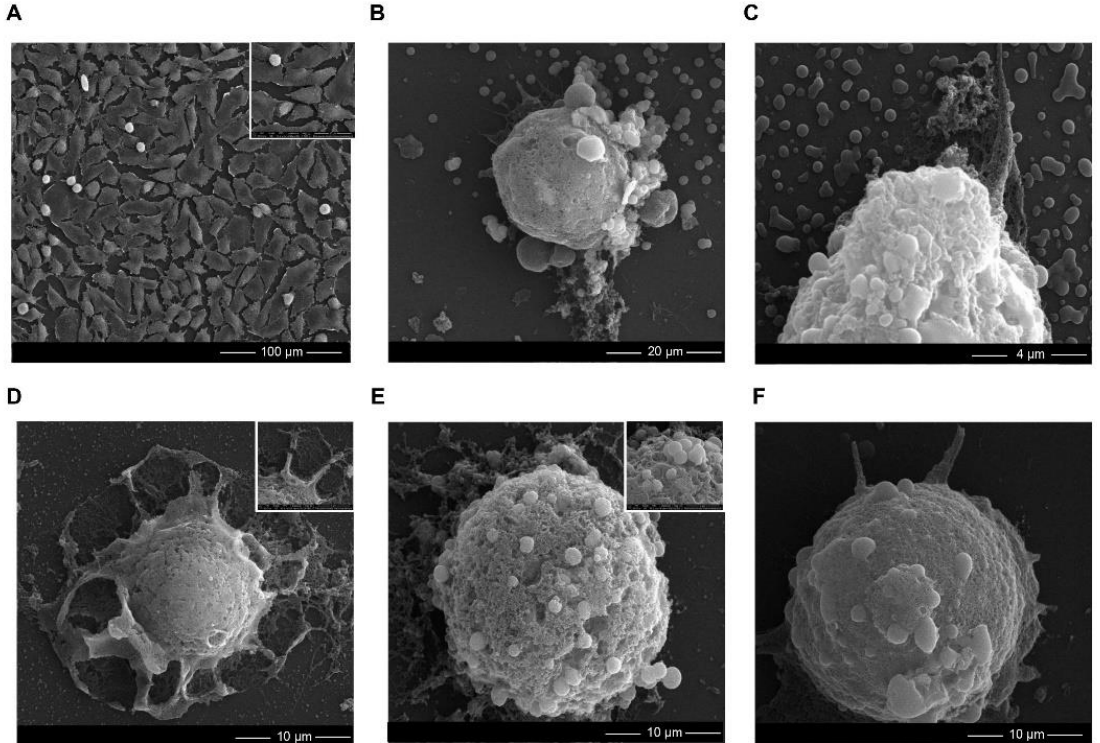
Figure 5. SEM analysis showing the morphology changes in L929 cells after the bare and functionalized ZnO NPs treatement. ( A ) control sample and L929 cells after the ( B ) extracellularly, ( C ) phytochemically, ( D ) intracellularly, ( E ) chemically and ( F ) biochemically synthetized ZnO NPs’ exposure. The concentration of the used ZnO NPs was 6.25 μg/mL.